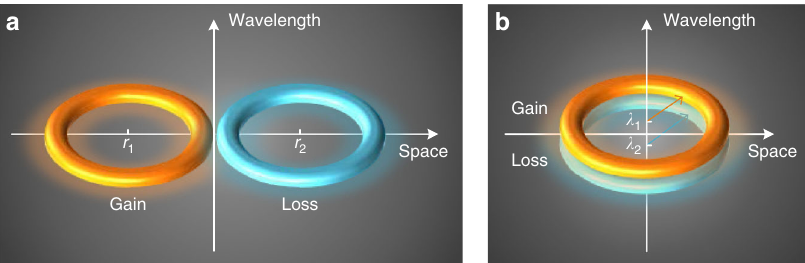
Fig. 1 Comparison of a spatial PT-symmetric system and a PT-symmetric system in the parameter space of wavelength. a A conventional PT-symmetric system with binary spatial arrangement with two subspaces located at r 1 and r 2 20 ; b the proposed PT-symmetric system in the parameter space of wavelength with two subspaces located at λ 1 and λ 2 . The two subspaces are non-distinguishable in terms of spatial location, i.e., they fully overlap in space and the footprint is only half that of its